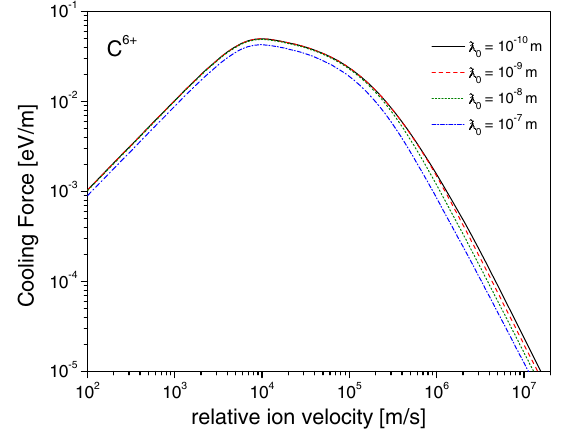
FIG. 10. Longitudinal cooling force (in eV = m ) for the C 6 þ ion as a function of the relative ion velocity (in m = s ). The theoretical ¼ cooling force (54) is calculated for an electron beam with n e 10 6 cm (cid:1) 3 , T ¼ 0 : 11 eV , and T ¼ 0 : 1 meV in a magnetic field ? k of B ¼ 0 : 1T for (cid:2) 0 ¼ 10 (cid:1) 10 m (solid line), (cid:2) 0 ¼ 10 (cid:1) 9 m (dashed line), (cid:2) 0 ¼ 10 (cid:1) 8 m (dotted line), and (cid:2) 0 ¼ 10 (cid:1) 7 m